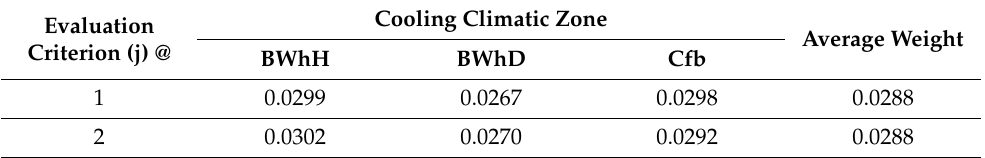
Table 10. E j entropy weight values for criterion related to cooling climatic